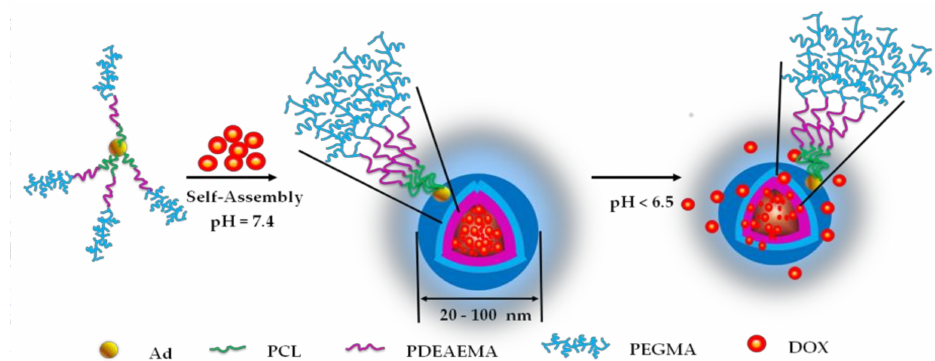
Scheme 1. Illustration of the formation of the drug-loaded adamantane-[poly( ε -caprolactone)- b